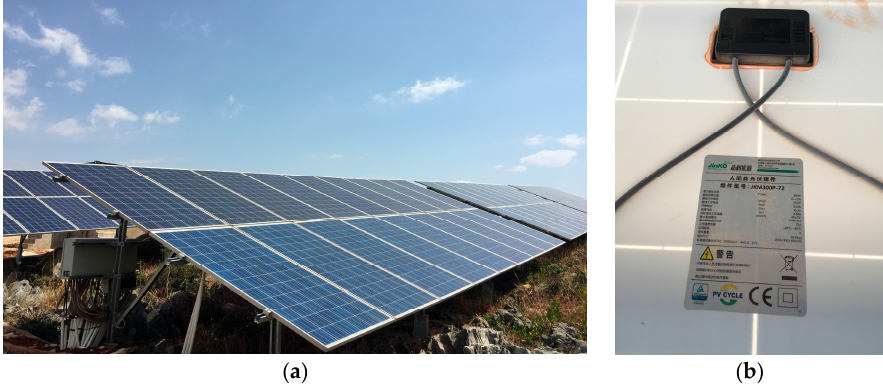
Figure 3. The PV modules installed in the plant: ( a ) PV array; and ( b ) PV module. Table 1. Parameters of PV module. NOCT : normal operating cell temperature.